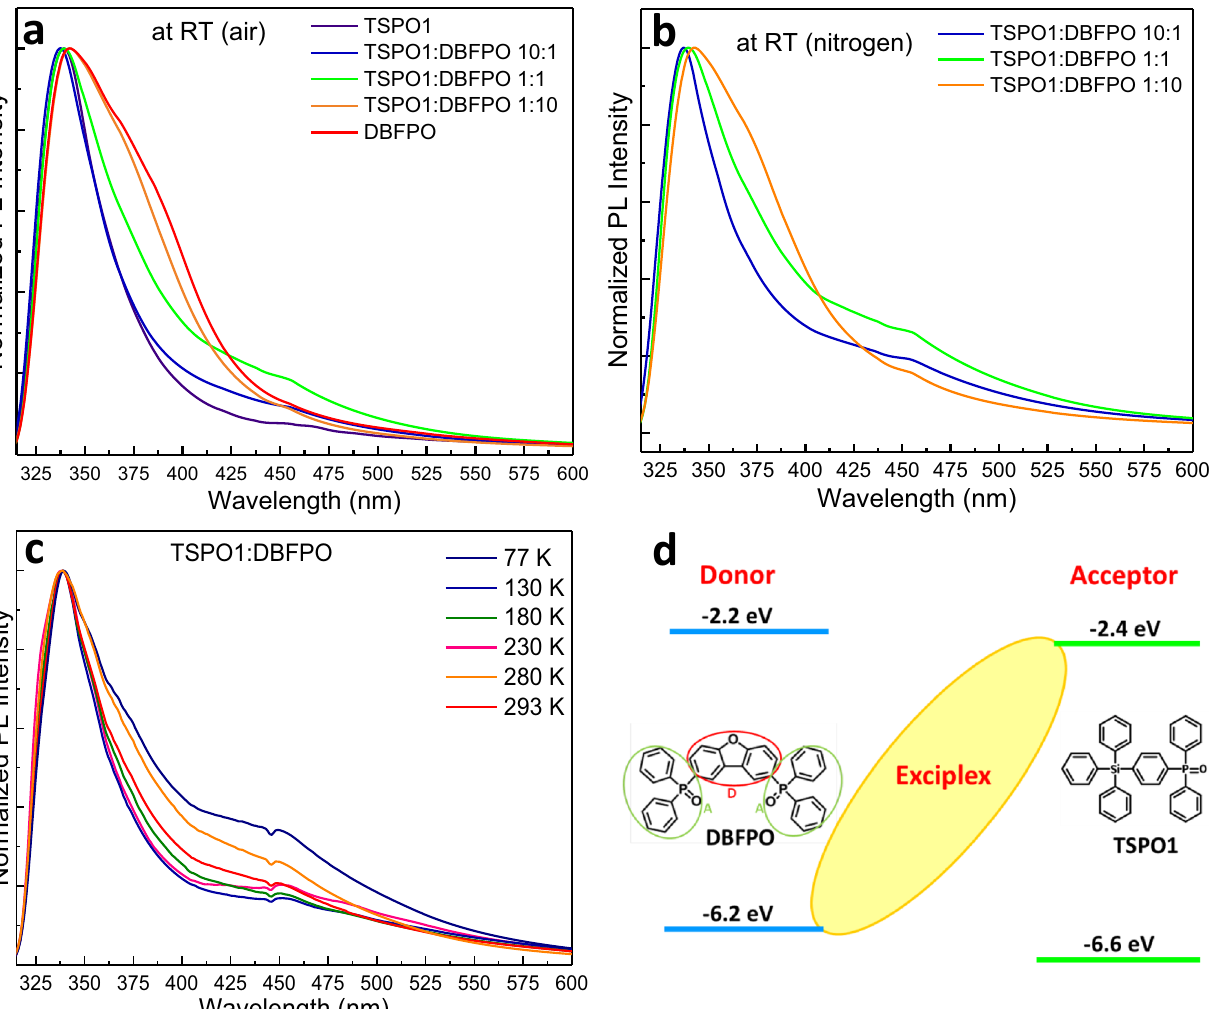
Fig. 2 Illustration of the interface exciplex formation. a Room temperature (RT) normalized PL spectra of TSPO1 and DBFPO pristine fi lms and mixtures. b The PL spectra of mixtures taken at RT in nitrogen. c Temperature-dependent PL spectra of TSPO1:DBFPO 1:1 mixed fi lm. d The chemical structures and frontier orbitals of DBFPO and TSPO1, and the illustration of interfacial exciplex